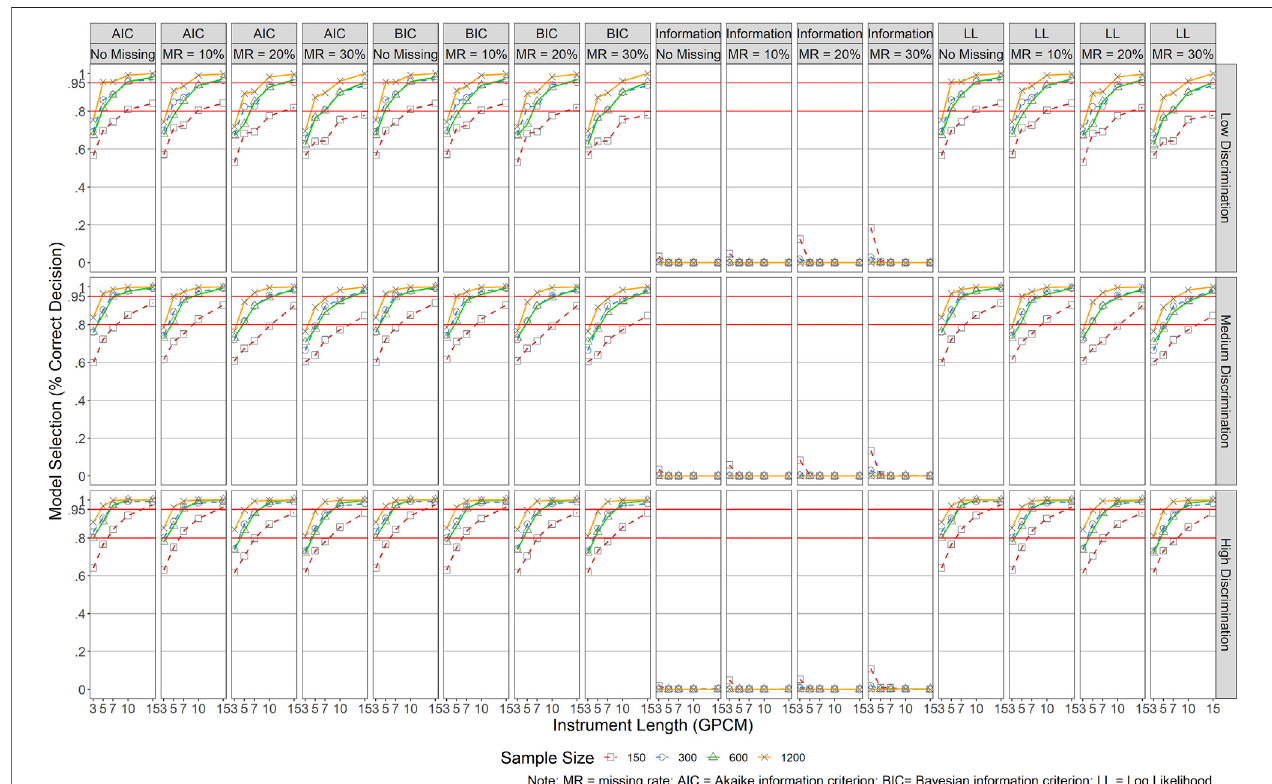
FIGURE11| ResultsofModelSpeci fi cation/SelectionforGPCM.Note.MR (cid:1) missingrate;AIC (cid:1) Akaikeinformationcriterion;BIC (cid:1) Bayesian informationcriterion; LL (cid:1) Log